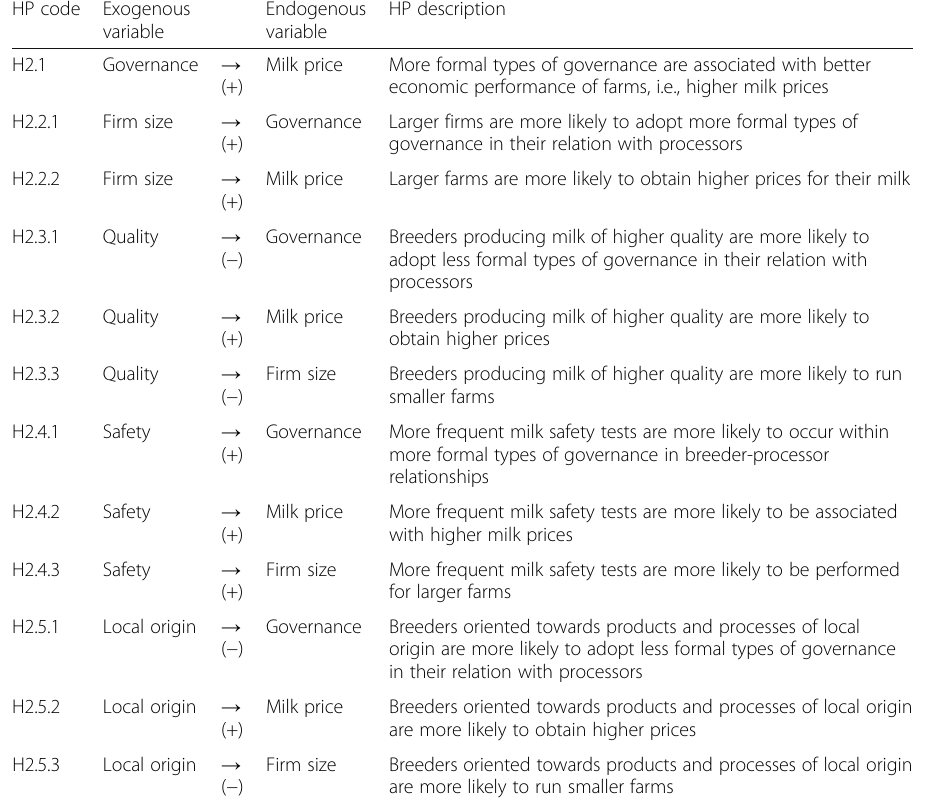
Table 2 Research hypotheses investigating the effects of product features on relational governance and firm economic